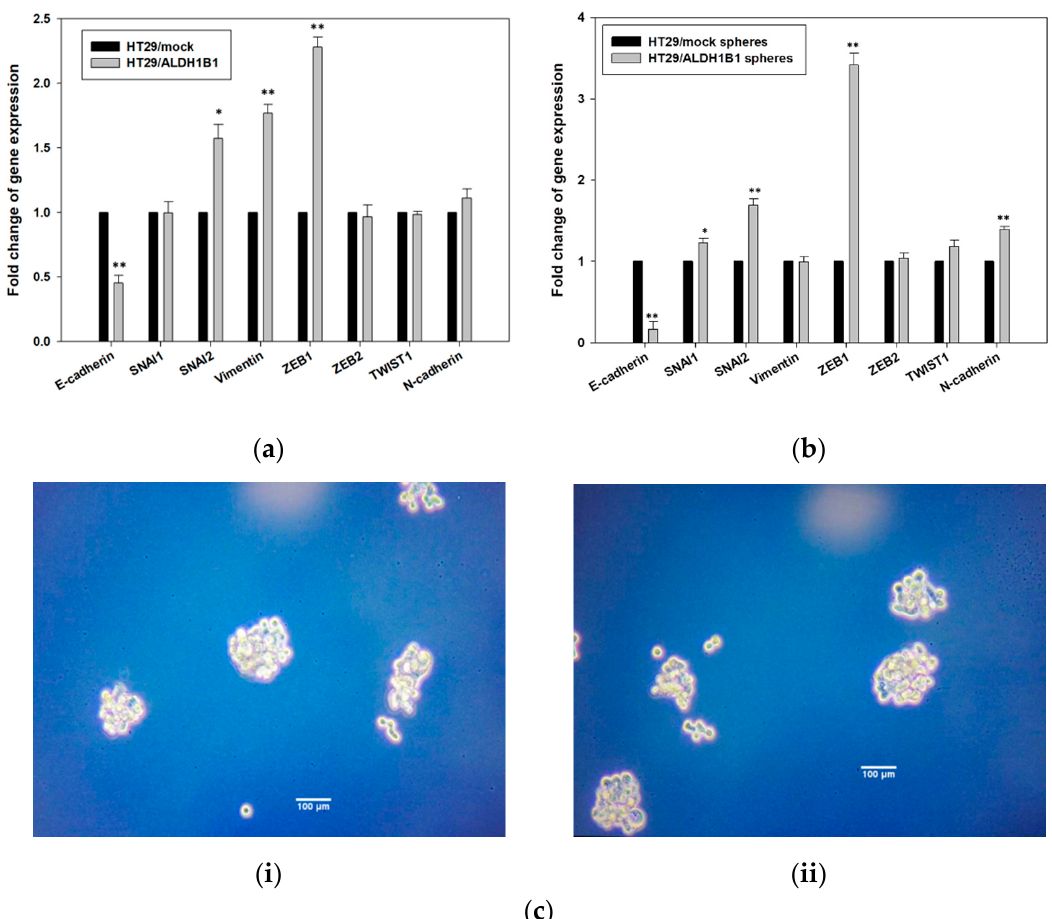
Figure 6. Expression of ALDH1B1 induces epithelial–mesenchymal transition (EMT) in HT29 cells and spheres. The effects of ALDH1B1 on the gene expression levels of EMT-related transcription factors in ( a ) differentiated and ( b ) cancer stem-like cells in the HT29 isogenic cell line pair. The comparative quantification ΔΔ Ct method was utilized for analyzing the fold change in the gene expression levels. β -actin gene was used as the endogenous control for the normalization of the samples. ( c ) Representative images of ( i ) HT29/mock and ( ii ) HT29/ALDH1B1 spheres (magnification 20x), which were typically formed in approximately 10 days. Results are shown as mean ± SD. At least three independent experiments were performed under each experimental condition. * p < 0.05 and ** p < 0.01.